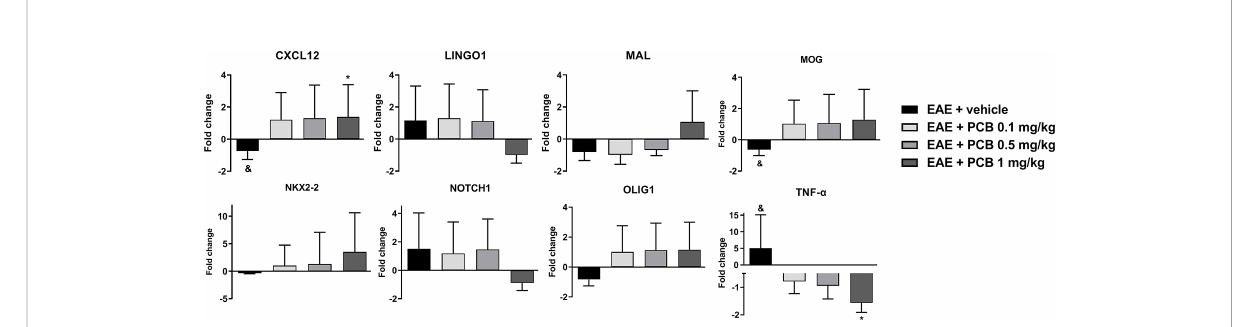
FIGURE 3 Effect of PCB on expression levels of demyelinating/remyelinating-related genes assessed by Real Time PCR in the brain of EAE mice. The panels show the mRNA levels of CXCL12 , LINGO1 , MAL , MOG, NKX2-2, NOTCH1, OLIG1 and TNF- a . MOG 35 – 55 immunized mice received a daily i.p. injection of PBS (vehicle) or PCB at 0.1, 0.5 or 1 mg/kg, from day 0 until day 26 post-immunization. Data are expressed as mean ± S.E.M. (n=4 per group). The ampersand (&) and asterisk (*) are indicative of signi fi cant differences with non-immunized naïve and vehicle-treated EAE mice, respectively (*p<0.05, & p<0.05, REST ©